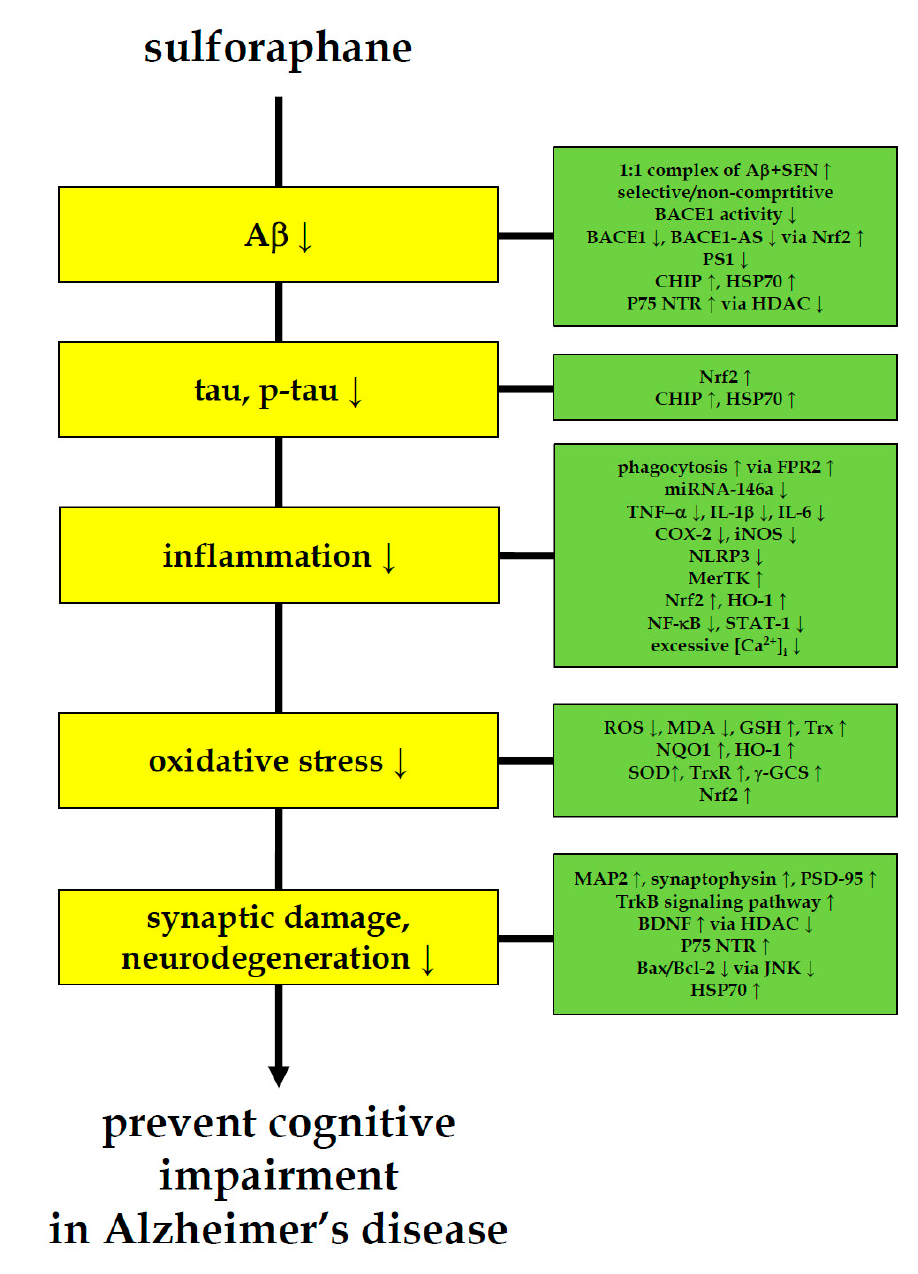
Figure 1. Multi-faceted anti-AD-like activity of sulforaphane. Sulforaphane ameliorates cognitive impairment and decreases the level of AD biomarkers for amyloid- β , tau, inflammation, oxidative stress and neurodegeneration in AD-like animal and cell models. These anti-AD-like evidences of sulforaphane indicate the need to pursue sulforaphane research in pre-symptomatic AD patients.